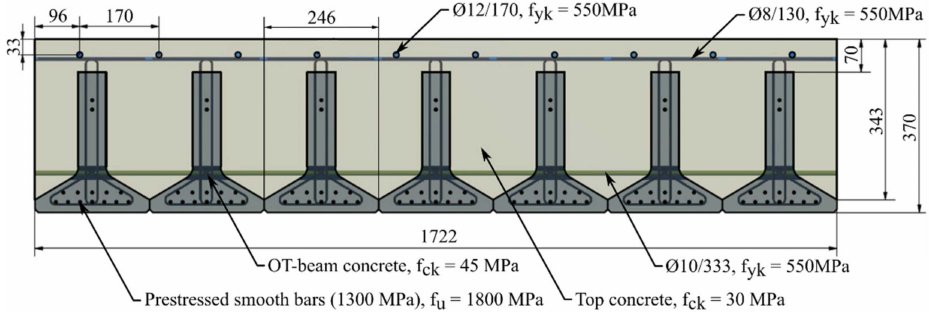
Figure 2. OT test specimen cross-section, all units in mm.